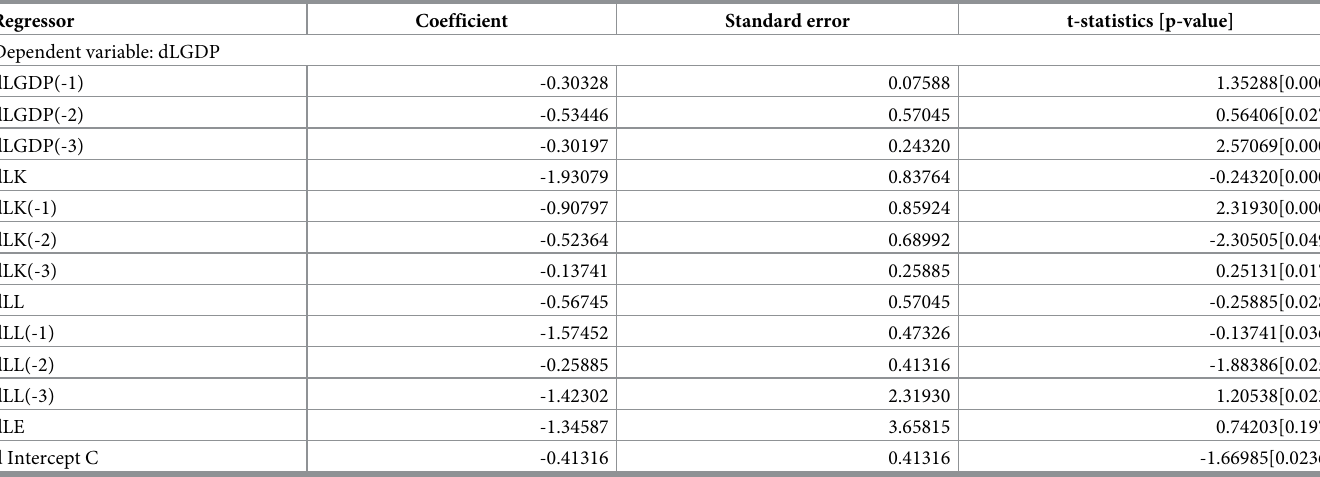
Table 5. Estimated coefficient matrix of VEC